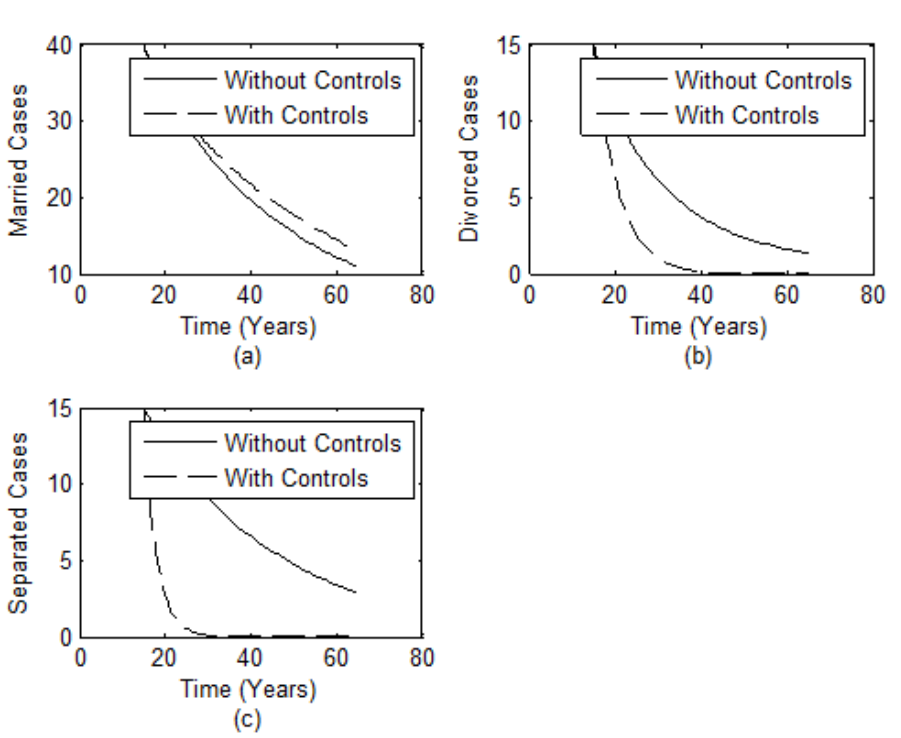
Figure 2. Impact of control measures (anti-divorce therapy and reconciliation) on (a) Married cases (b) Divorced cases (c) Separated cases using parameter values in Table